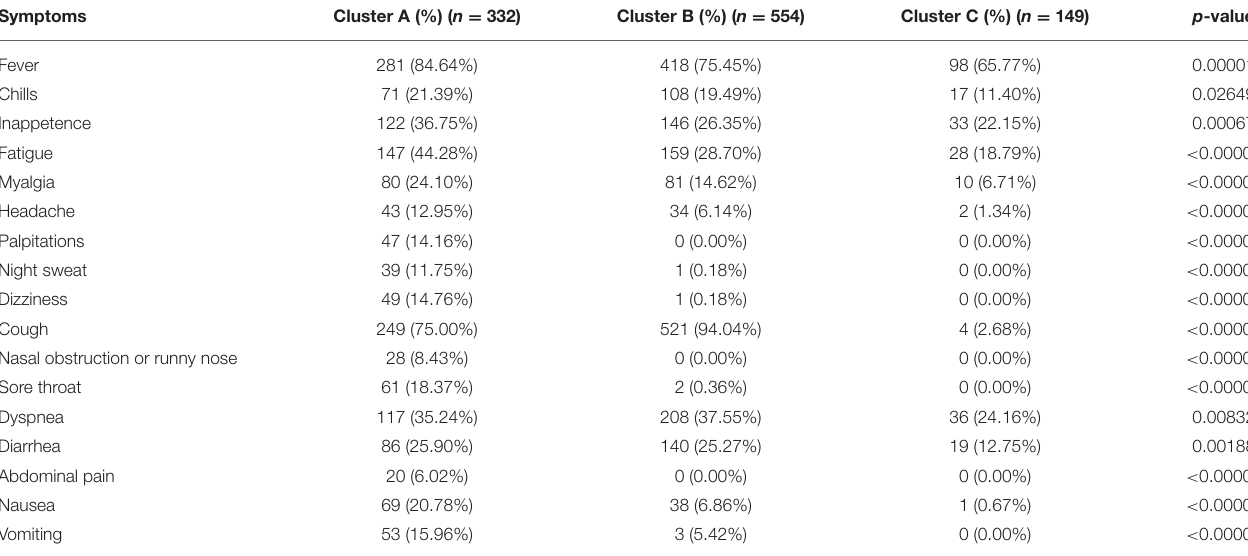
TABLE 6 | Frequencies of symptoms of three COVID-19 clusters identified by Factor Analysis of Mixed Data-based cluster analysis. Symptoms Cluster A (%) ( n = 332)